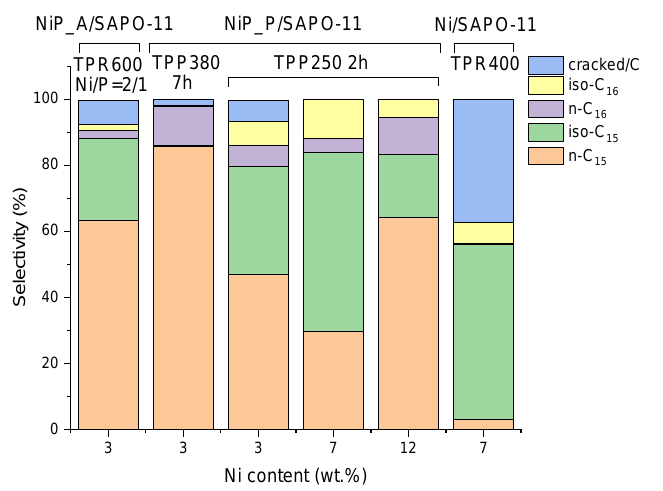
Figure 7. Product distributions over Ni-phosphide and Ni catalysts on SAPO-11 in a continuous-flow reactor (X MP = 100%). T = 340 °C, 2 MPa, LHSV = 5.3 h −1 , 600 Ncm 3 /cm 3 .